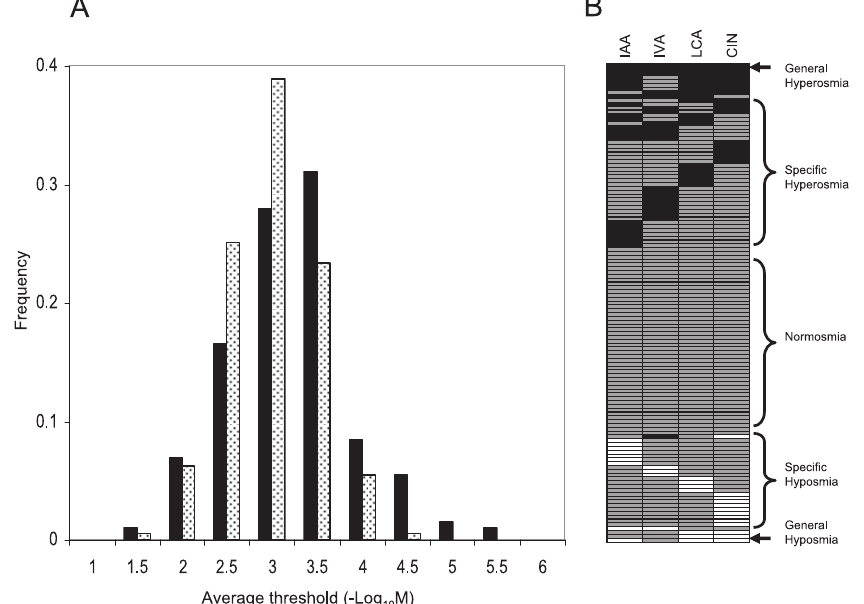
Figure 5. Excess of General Hyperosmia (A) Histogram of average olfactory thresholds (adjusted for gender). The average threshold values for the four odorants were calculated for the raw data (black bars) and for data generated by 1,000 permutations of the individual odorant thresholds (dotted bars). The significantly broader distribution of the original data as compared to the permutated data (ANOVA, F ¼ 1.83, p ¼ 1.68 3 10 (cid:2) 10 ) indicates an excess of individuals with extreme threshold values, particularly in the hypersensitivity end of the distribution. (B) Combinations of odorant thresholds (adjusted for gender) for the four odorants. Shown are hyperosmia (lowest 10% of thresholds in the entire sample, black), normosmia (middle 80%, gray), and hyposmia (highest 10%, white). Individuals with similar threshold patterns are clustered together. For clarity, only 50 of the total of 123 normosmic individuals are shown. The probability of observing three individuals defined as generally hyperosmic (i.e., having hyperosmia to all four odorants) in this cohort is computed as ; 10 (cid:2) 12 .